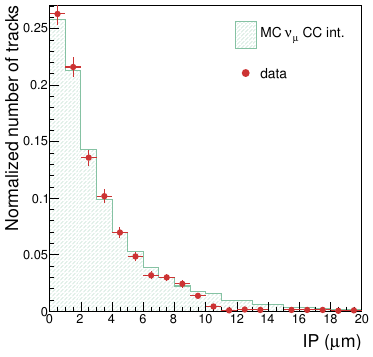
Figure 2. Track impact parameter distribution for a sample of located ν μ CC interactions, compared to MC